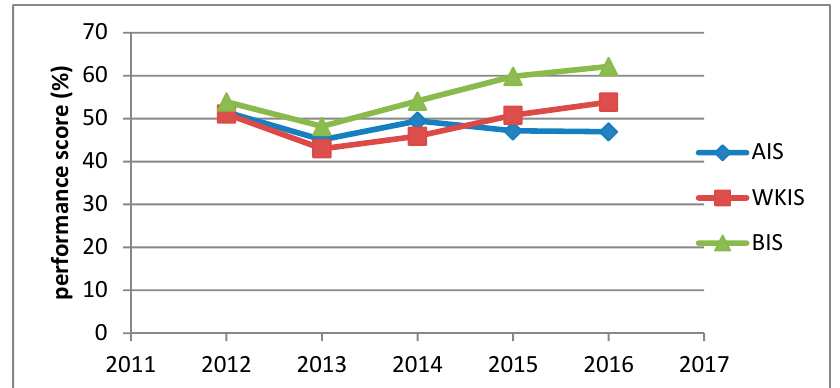
Figure 2. Comparison of performance score.